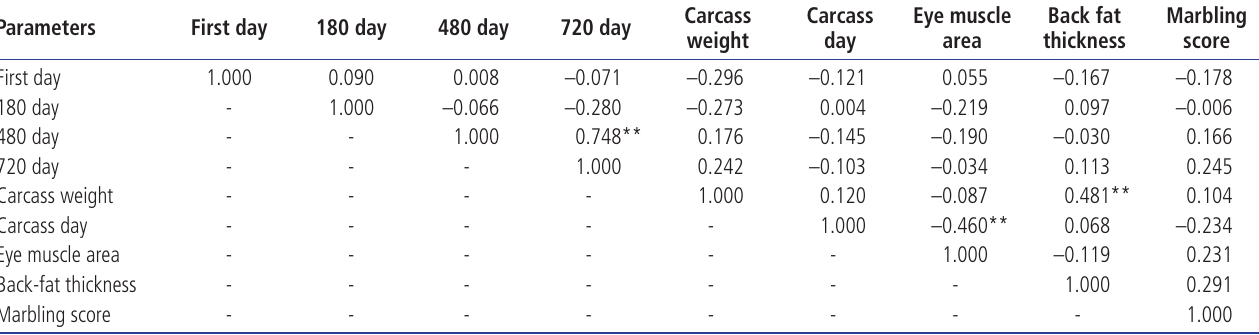
Table 4. Correlation analysis of growth pattern and carcass characteristics of great meat yield group